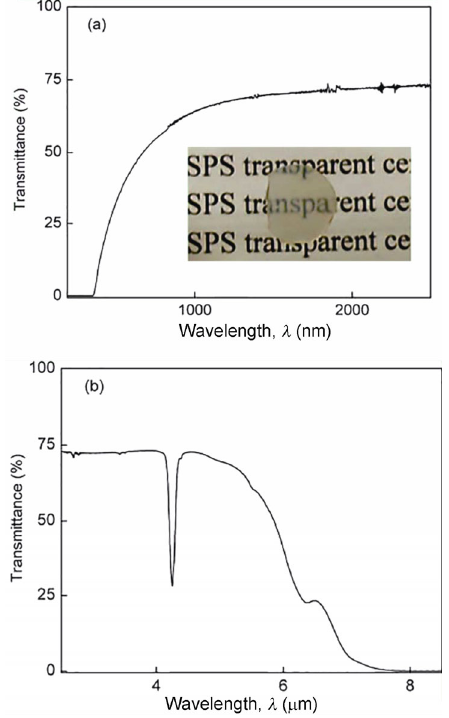
Fig. 21 Transmittance and photograph of Lu 2 Ti 2 O 7 transparent ceramic (0.8 mm thick). Reproduced with permission from Ref. [50], © Elsevier Ltd. 2010.